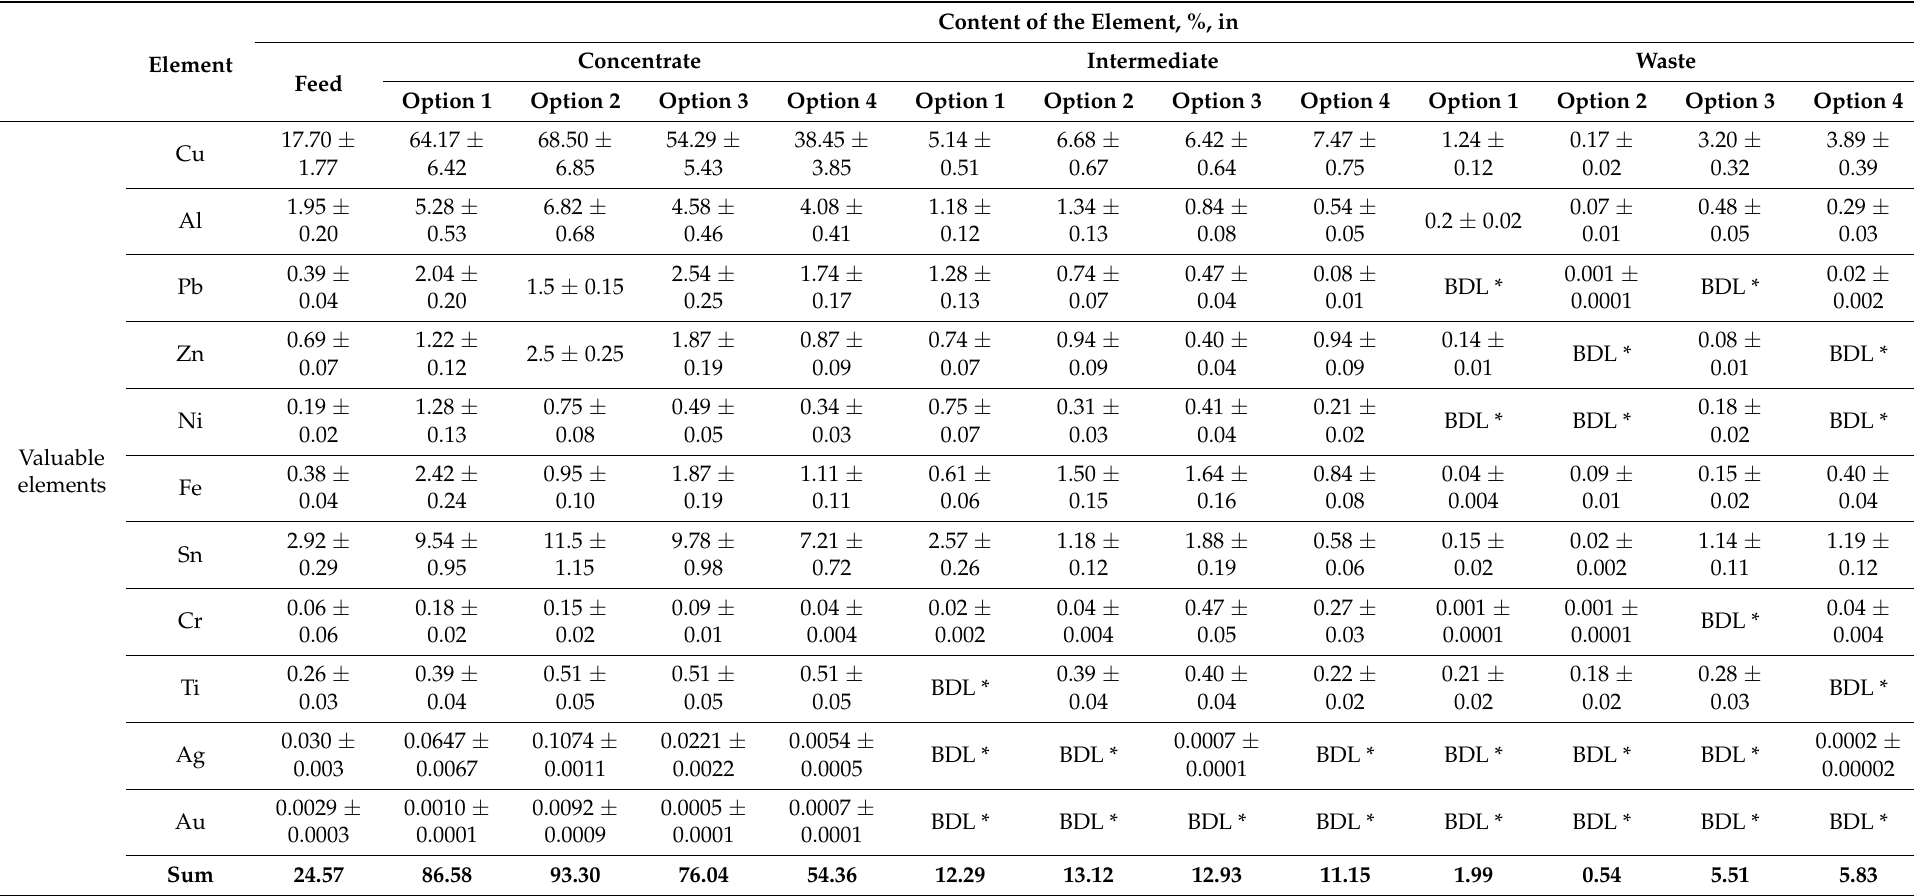
Table 3. Elemental content in the feed and electrostatic separation products for all grinding